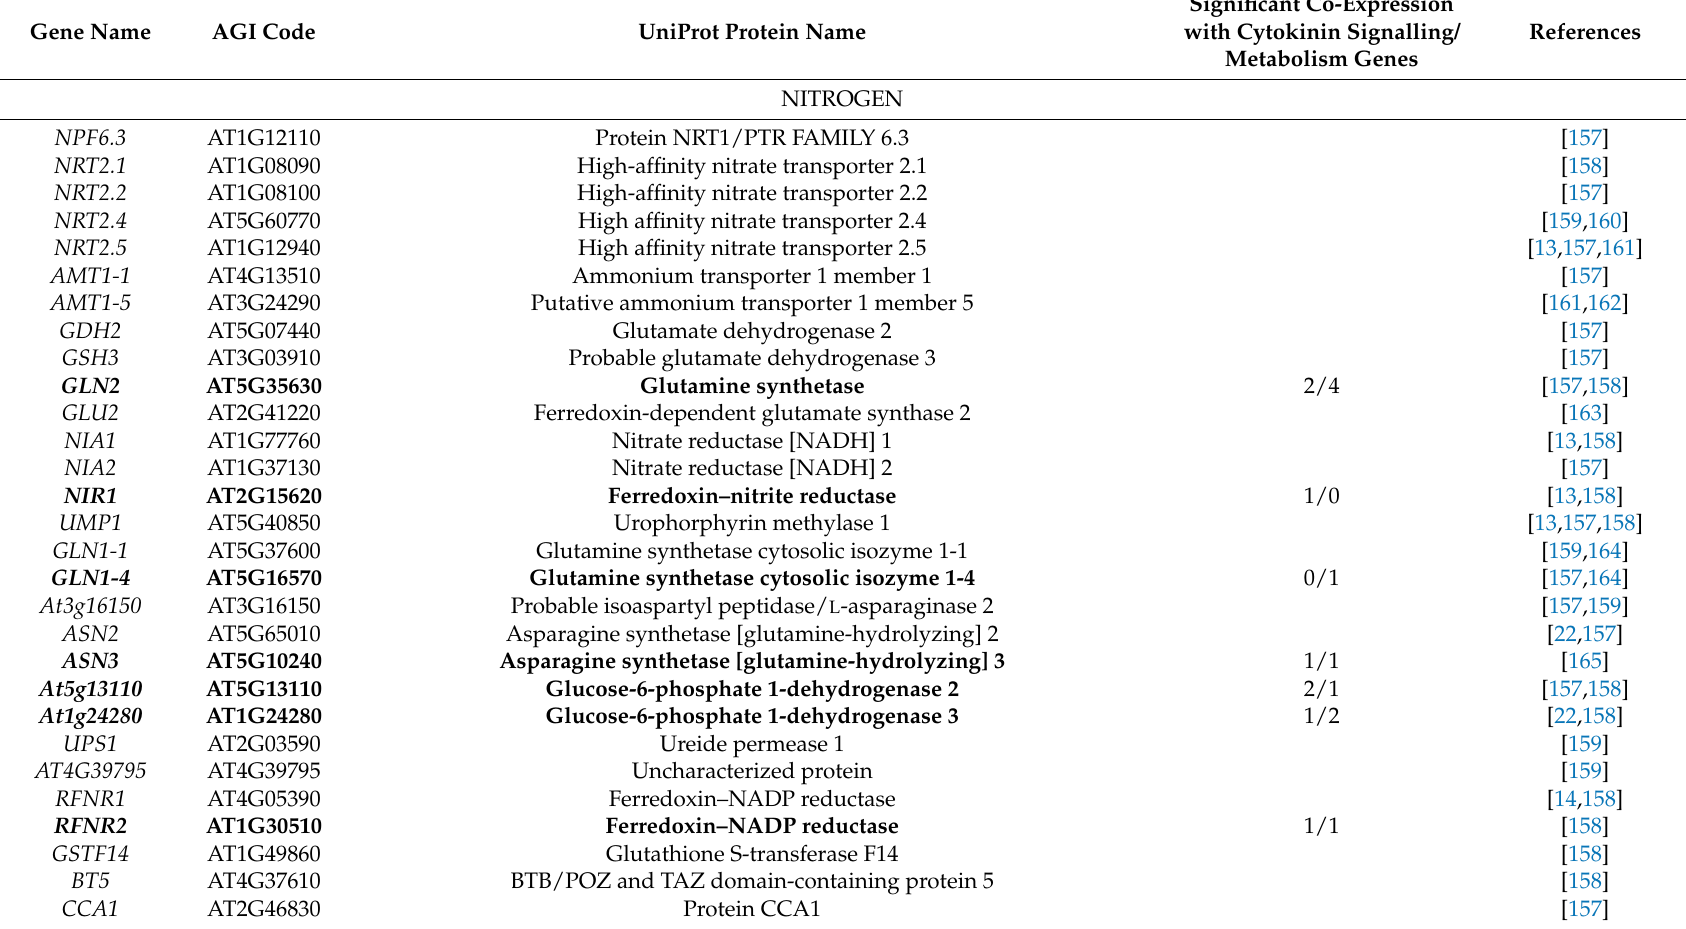
Table 1. List of all abiotic stress-related genes, with references, and their putative interactions with cytokinin according to the expression profile analysis outlined in Figures 2–4. Genes in bold indicate profile similarities >85% to cytokinin-related genes, and numbers indicate the number of detected co-expressed cytokinin signalling/metabolism